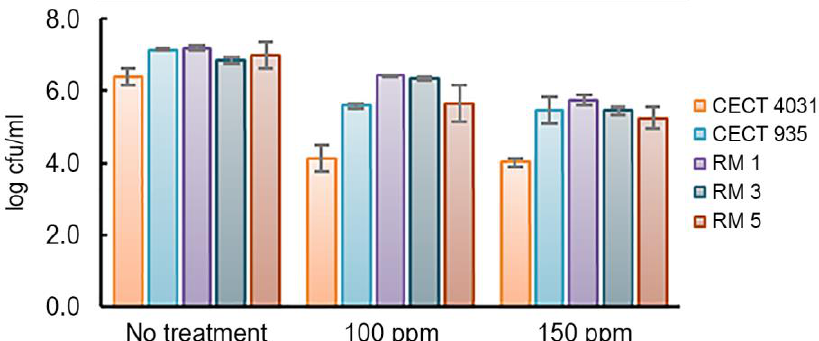
Figure 4. Average and standard deviation (error bars) of tested L. monocytogenes 5-day-old biofilms’ VCC after QaC treatment.